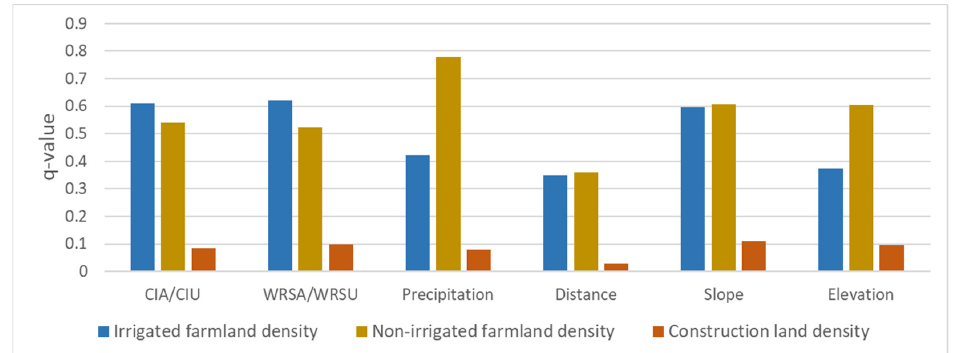
Figure 10. The q-statistic of water and land resources indicators influencing cultivated land and construction land spatial distribution.